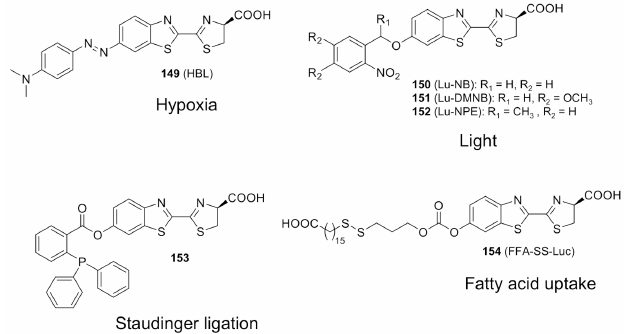
Figure 10. Chemical structures of bioluminescence probes for hypoxia, light, Staudinger ligation, and fatty acid